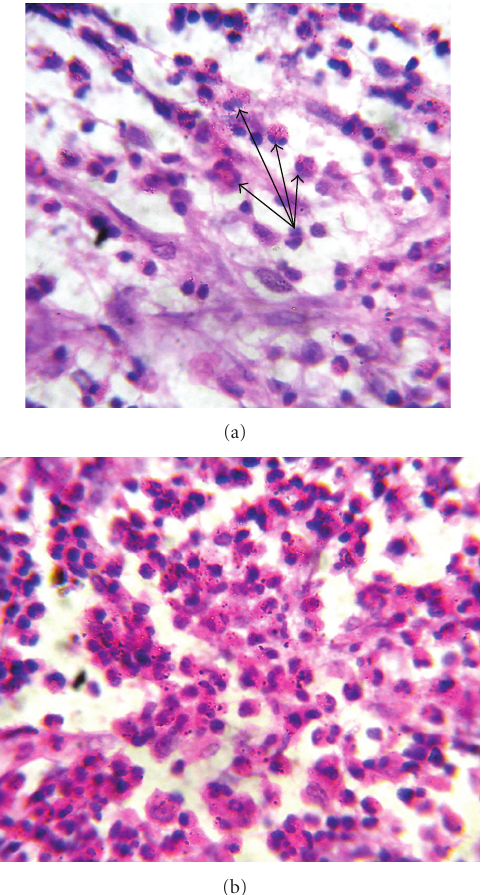
Figure 3: (a) Photomicrograph showing an admixture of inflam- matory cells, including occasional Eosinophils (arrows). (H&E, × 100). (b): Photomicrograph showing clusters of large lesional cells with abundant bright pink cytoplasm and reniform nucleus. (H&E, ×